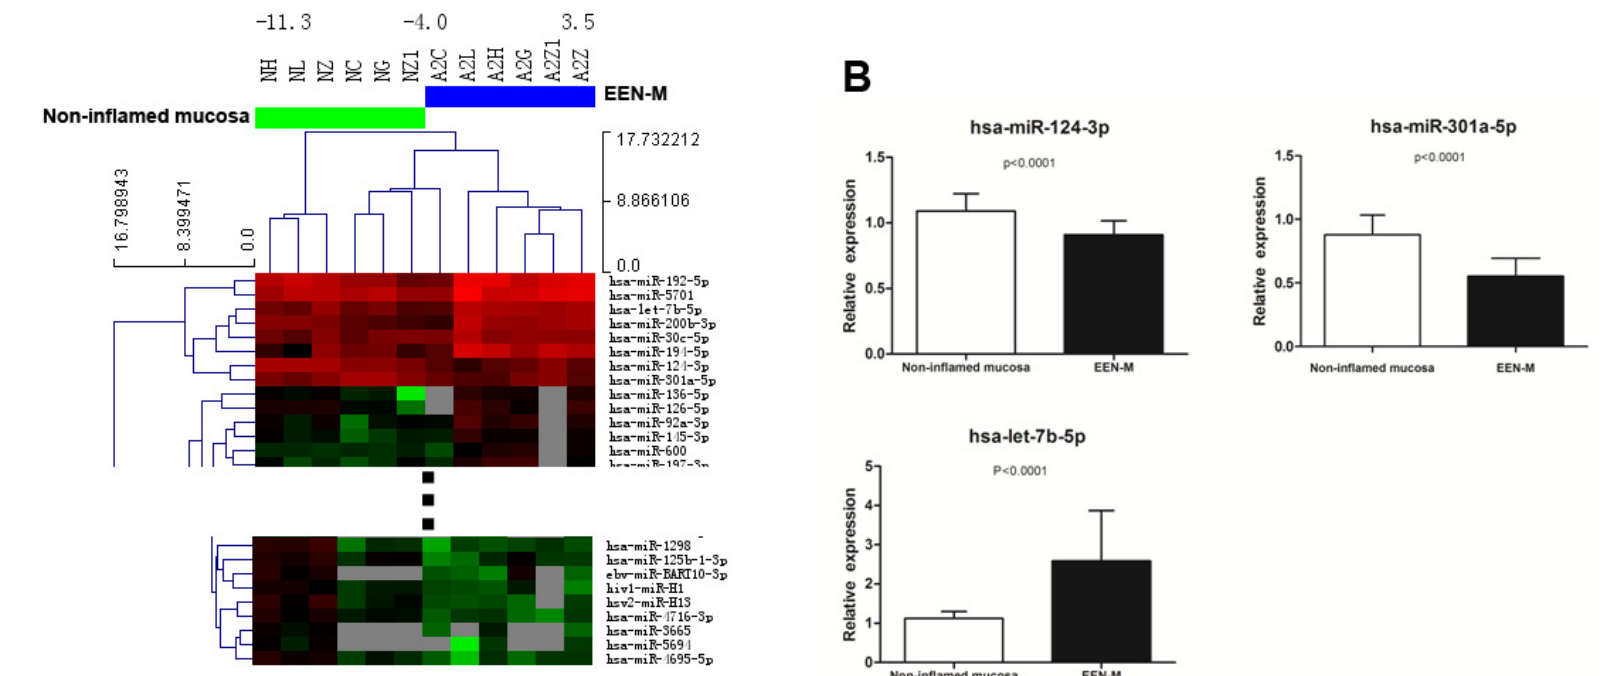
Figure 2. Comparison between non-inflamed mucosa of active CD and EEN-M: ( A ) heat map of differentially expressed miRNAs could not separated non-inflamed mucosa of active CD and EEN-M; and ( B ) qRT-PCR validation of miRNAs differentially expressed in EEN ‐ M.